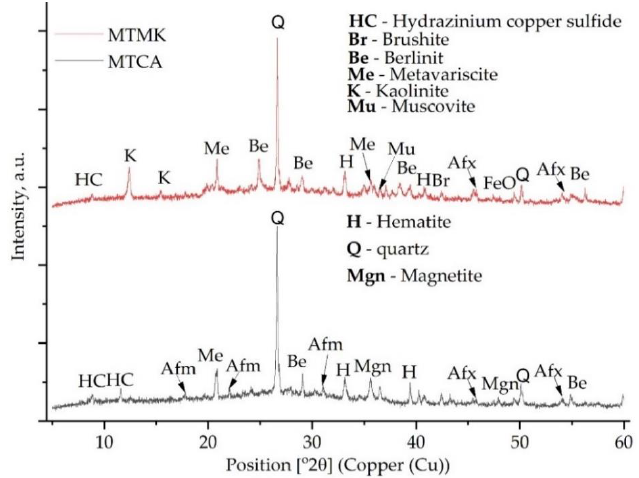
Figure 5. The XRD pattern of the acid-activated geopolymers with mine tailings.